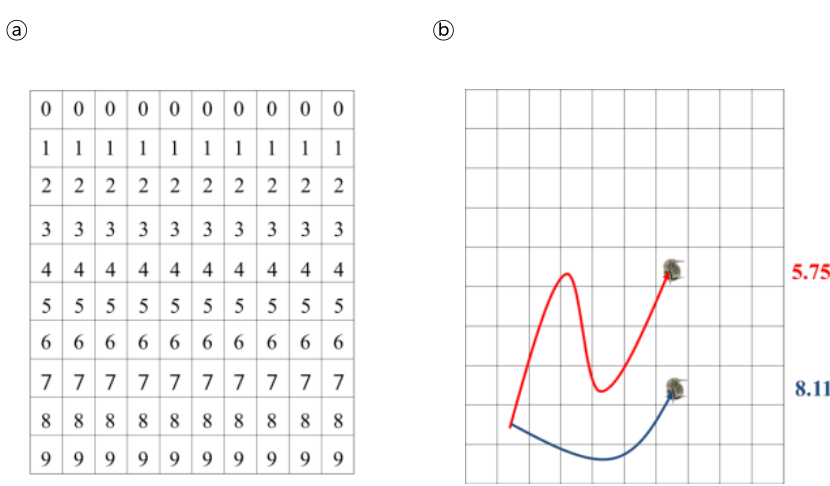
Figure 2. Recognition of swimming altitude of Daphnia magna . (a) Numbering sections 0 to 9 for recognition of each altitude. (b) Example of altitude recognition; the average altitudes of Daphnia magna colored red and blue are